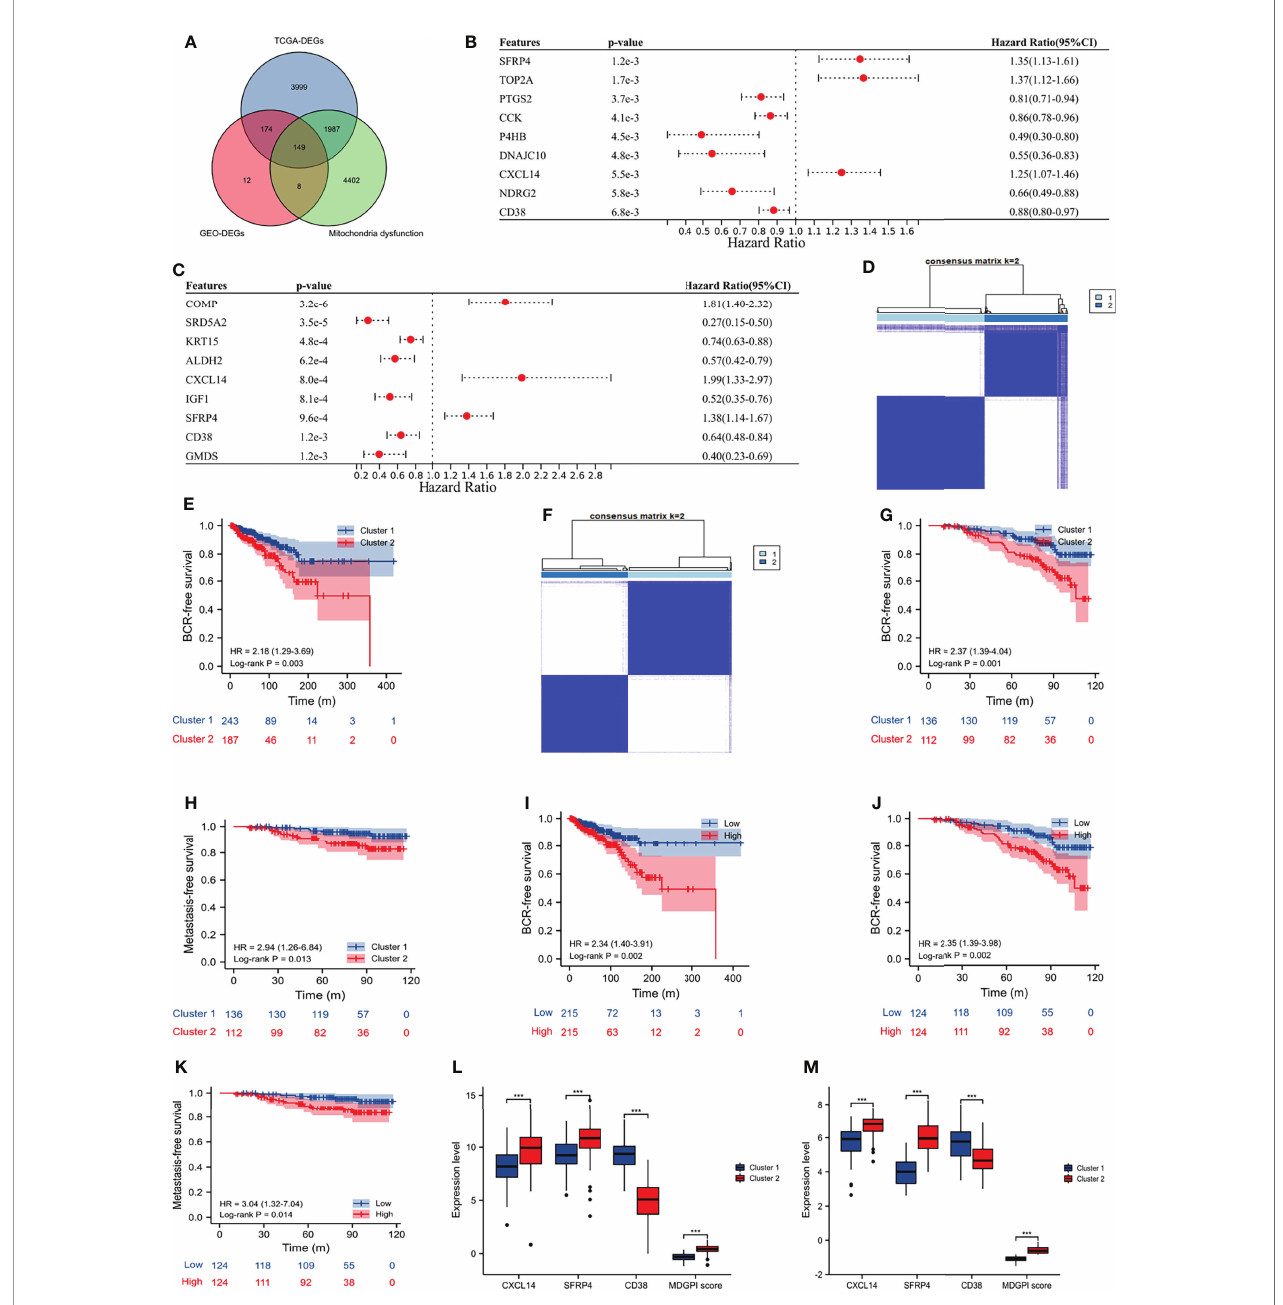
FIGURE 2 | Molecular subtype and MDGPI score. (A) Venn plot showing the interaction of differentially expressed genes between tumor and normal samples in the TCGA and GEO datasets, and mitochondrial dysfunction-related genes; (B) forest plot showing genes associated with BCR-free survival in the TCGA database; (C) forest plot showing genes associated with BCR-free survival in the GSE116918 (17); (D) cluster plot showing distinct two groups in the TCGA database; (E) Kaplan – Meier curve presenting the BCR-free survival difference of the two clusters in the TCGA database; (F) cluster plot showing distinct two groups in the GSE116918 (17); (G) Kaplan – Meier curve presenting the BCR-free survival difference of the two clusters in the GSE116918 (17); (H) Kaplan – Meier curve presenting the metastasis-free survival difference of the two clusters in the GSE116918 (17); (I) Kaplan – Meier curve presenting the BCR-free survival difference of the high- and low-risk groups based on the median of MDGPI in the TCGA database; (J) Kaplan – Meier curve presenting the BCR-free survival difference of the high- and low-risk groups based on the median of MDGPI in the GSE116918 (17); (K) Kaplan – Meier curve presenting the metastasis-free survival difference of the high- and low-risk groups based on the median of MDGPI in the GSE116918 (17); (L) comparisons between cluster 2 and cluster 1 in the TCGA database for CXCL14, SFRP4, CD38, and MDGPI score; (M) comparisons between cluster 2 and cluster 1 in the GSE116918 (17) for CXCL14, SFRP4, CD38, and MDGPI score. BCR, biochemical recurrence; MDGPI, mitochondrial dysfunction-related genetic prognostic index. ***, p